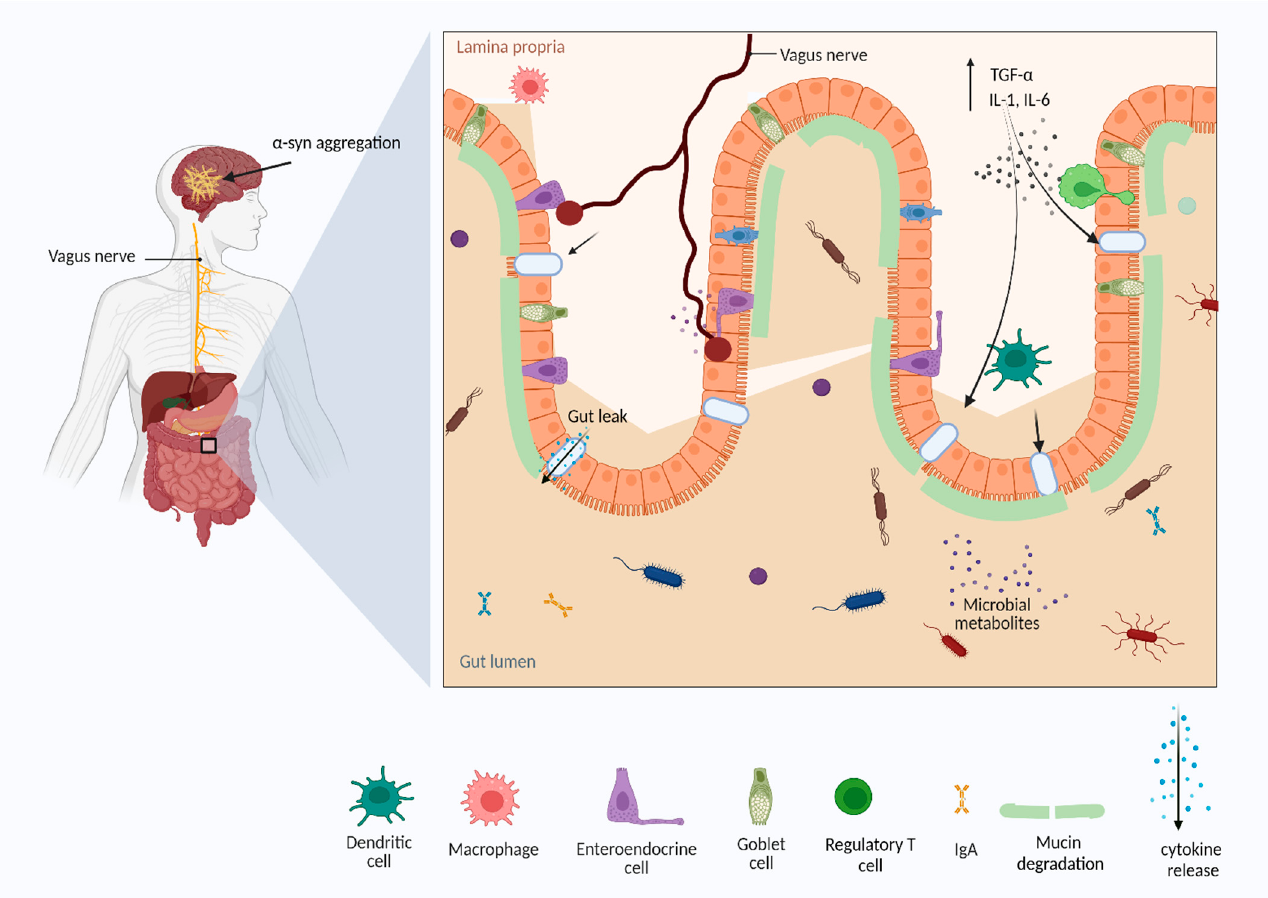
Figure 3. The gut dysbiosis and Parkinson’s disease. Gut dysbiosis and defects in intestinal barrier function facilitate the release of material metabolites, endotoxins, and other antigens into the gas- trointestinal system, which further activates the immune system and the release of pro-inflammatory cytokines. Chronic immune activation may cause neuroinflammation and neurodegenerative diseases (Figure created using BioRender.com).